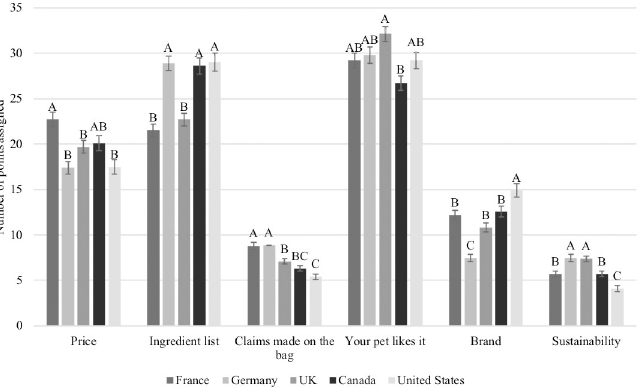
Fig 8. Mean ( ± SD) score assigned to each factor involved in selecting a pet food among countries (n = 3,298). Proportions in the same category that do not share a common letter are significantly different at P < 0.05.